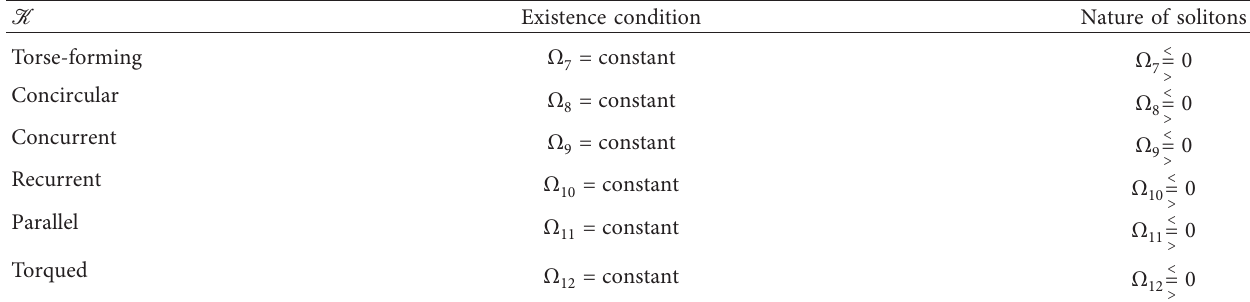
Table 3: Relationship between K , existence condition, and nature of